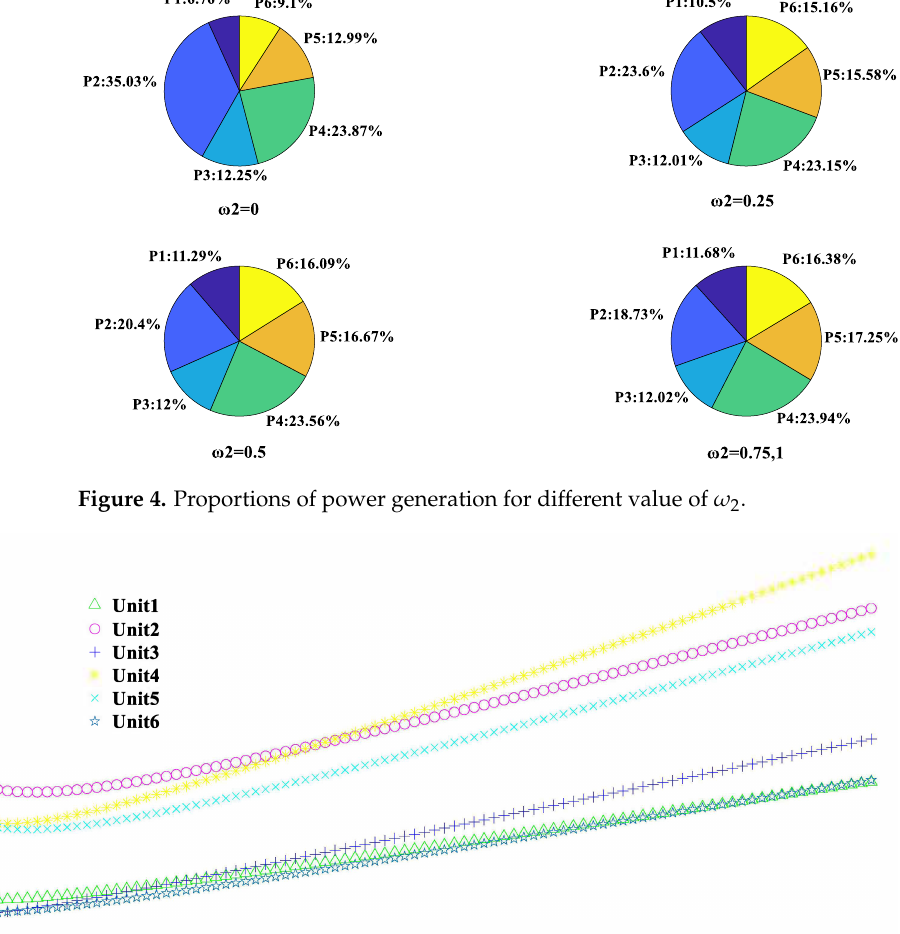
Figure 5. Unit emission between different